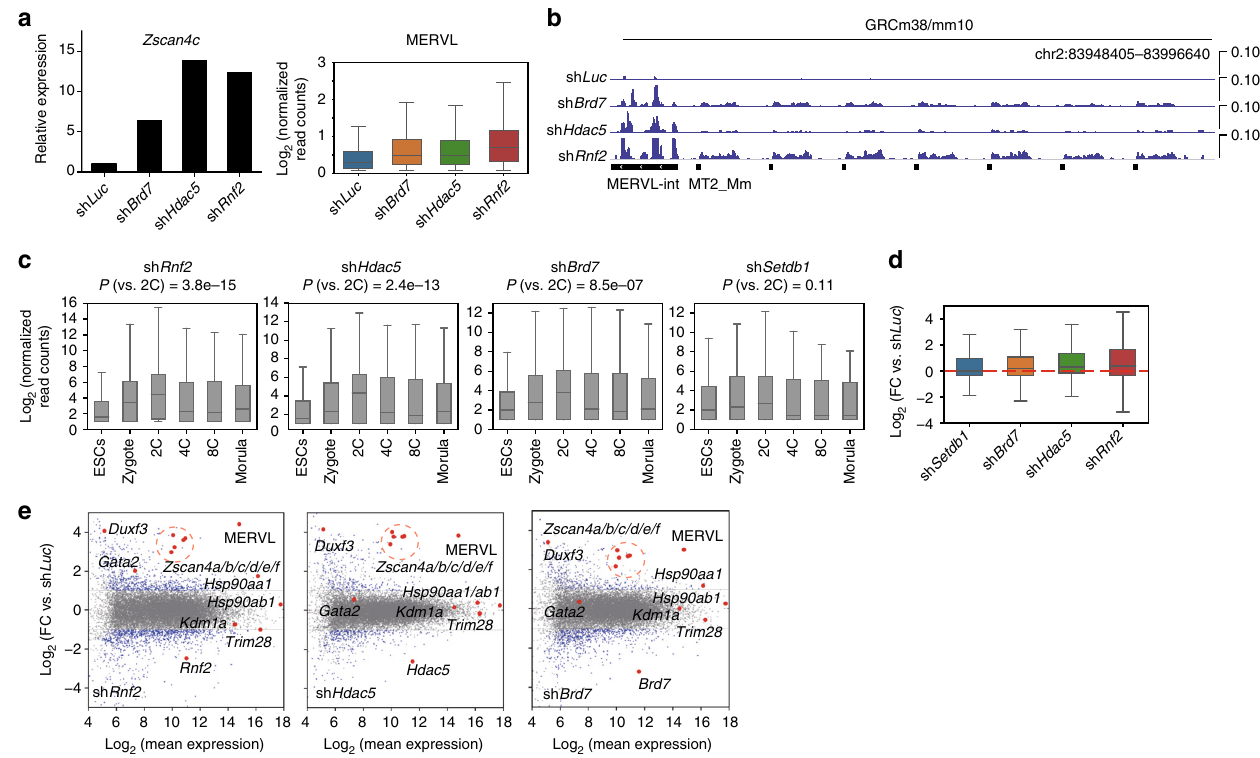
Fig. 5 Knockdown of chromatin modi fi ers activates a 2C-like gene expression program. a RNA-seq expression level of the 2C-related gene Zscan4c in the indicated knockdowns (left), and a boxplot showing the level of MERVL TEs in the same knockdown RNA-seq data. Bar chart values indicate the mean of the two biological replicates (sh Hdac5 or sh Rnf2 ), or a biological singlicate (sh Brd7 ), relative to sh Luc control knockdown. The boxplot shows the Log2 normalized read count mapping to the total set of MERVL TEs, from the same RNA-seq data. b Example genome view showing the RNA-seq pileup data and activation of MERVL-int and MT2_Mm TE expression in Brd7 , Hdac5 , and Rnf2 shRNA knockdowns. c Boxplot of RNA-seq expression for genes upregulated in the indicated knockdowns. For the sets of genes signi fi cantly upregulated in the indicated CM knockdown, their expression was measured in the indicated embryonic stages and in ESCs (RNA-seq data was taken from 60 ). P values are from a Mann – Whitney U test. The x -axis indicates the overall level of expression of the knockdown-speci fi c genes, in those cell types. d Upregulation of a 2C-related gene signature by the indicated CM knockdowns. A 2C-related gene signature was generated by taking the fold-change of all 2C genes versus ESCs and taking the top 200 fold-change upregulated genes. The expression of those top 200 2C genes was then measured in the indicated knockdowns, relative to sh Luc control. e MA-scatter plots showing the expression of all genes and TEs in the sh Rnf2 , sh Hdac5 , and sh Brd7 knockdowns. Labels and red spots indicate the expression of the shRNA target gene, the MERVL-int TE, and selected 2C-related genes ( Zscan4a/b/c/d/e/f -cluster, Duxf3 , Hsp90aa1 , Hsp90ab1 , and Gata2 ). Note that the effect is not related to deregulation of Trim28 or Kdm1a , two known MERVL regulators. For the boxplots in this fi gure, the midline indicates the median, boxes indicate the upper and lower quartiles and the whiskers indicate 1.5*interquartile